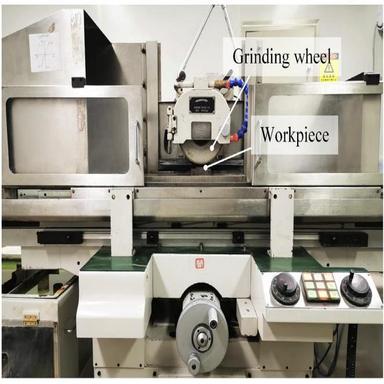
Set-up for grinding experiments.